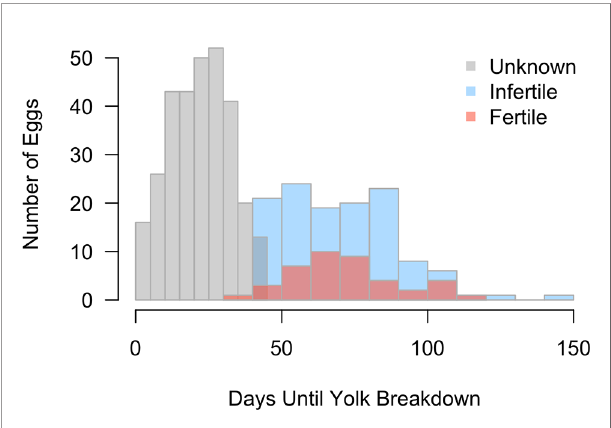
FIGURE 3 | Distribution of days until yolk breakdown is shown for eggs of Fertile (salmon), Infertile (blue) and Unknown fertility status (gray). Yolk breakdown in Unknown eggs was signi fi cantly earlier than either con fi rmed Fertile or Infertile eggs.